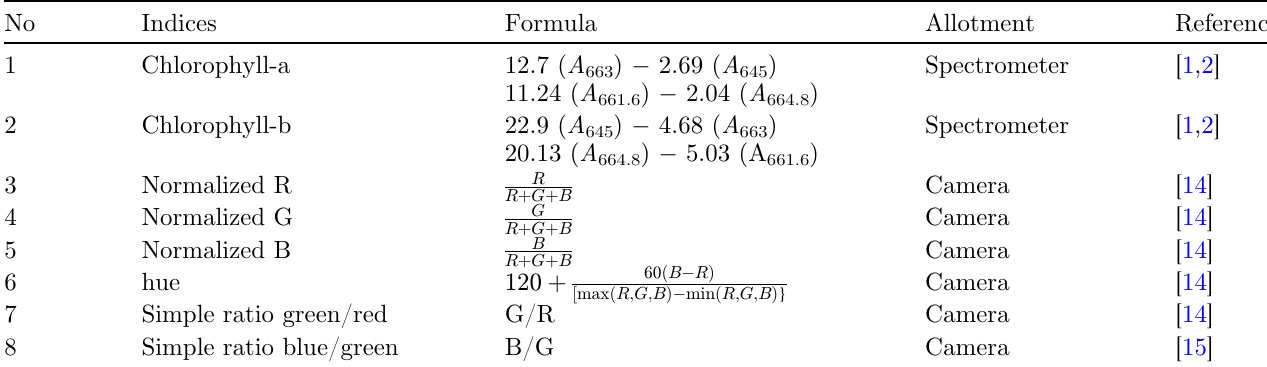
Table 1. Proposed indices for estimating water quality through absorbance techniques.